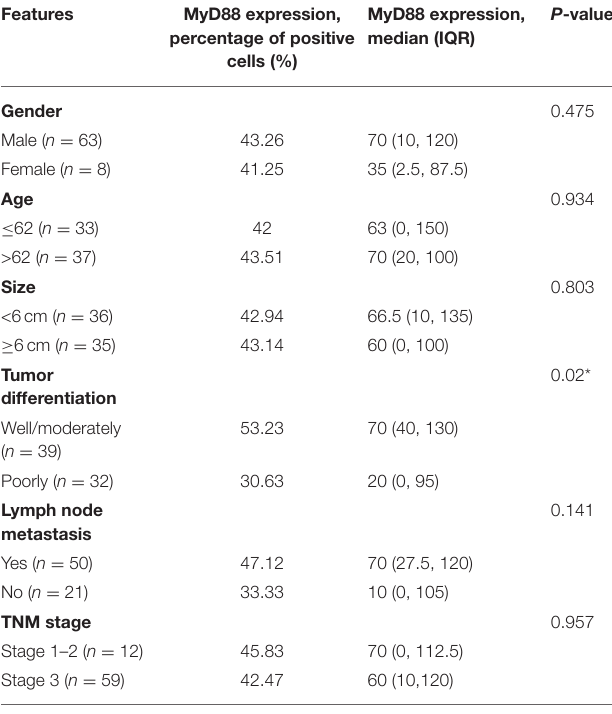
TABLE 3 | The associations of MyD88 expression with clinicopathologic characteristics concerning 71 of the 102 GCC patients. Features